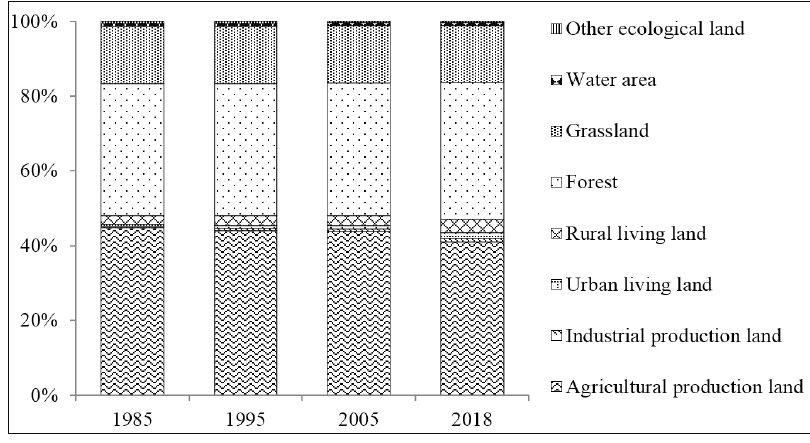
Figure 7. Carbon storage in different land use categories from 1985 to 2018.